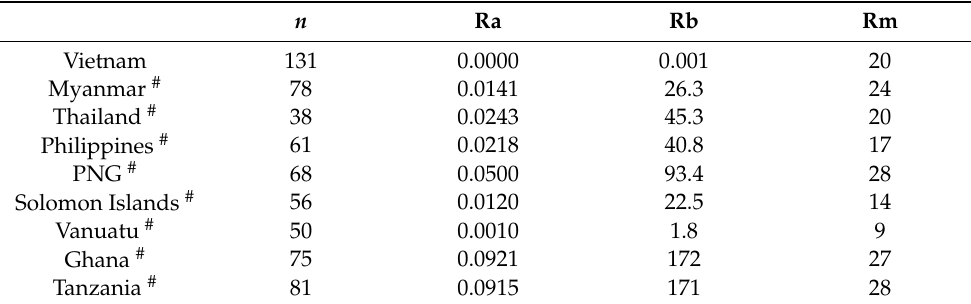
Table 3. Comparison of recombination events between global pfama-1.